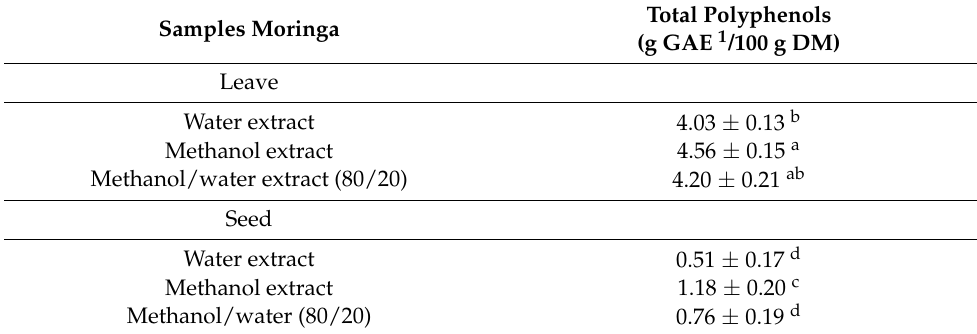
Table 3. Polyphenol content of different leaves and seed extracts from Moringa oleifera . All determi- nations were performed in triplicate and values shown are mean ± standard deviation. Different superscript letters indicate significant differences ( p <